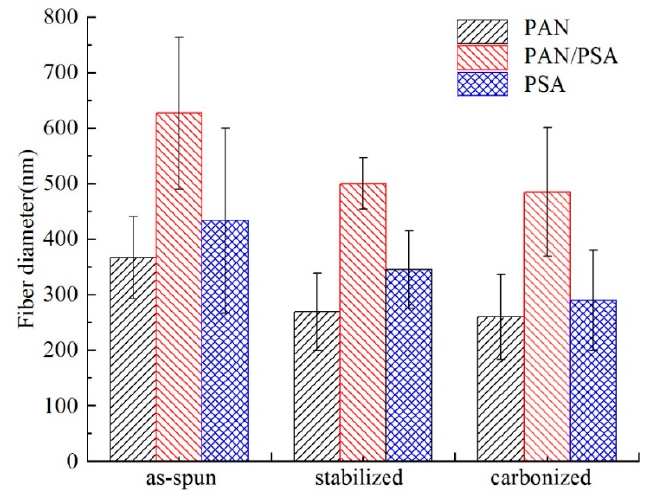
Figure 11. Comparison of the fiber diameter of PSA of different materials at different processing stages: ( a ) PAN; ( b ) PAN/PSA; ( c ) PSA.